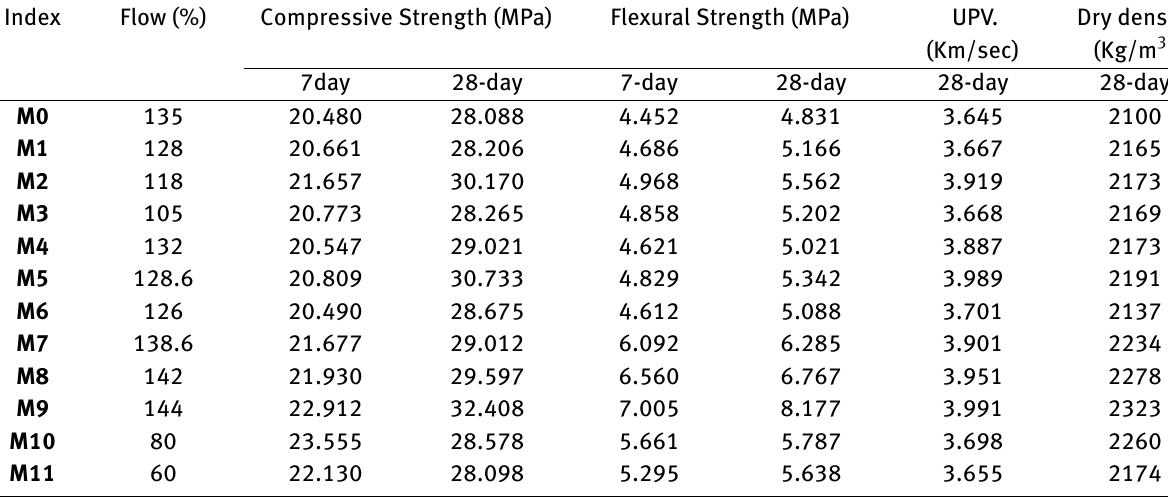
Table 10: Reinforced green mortar test